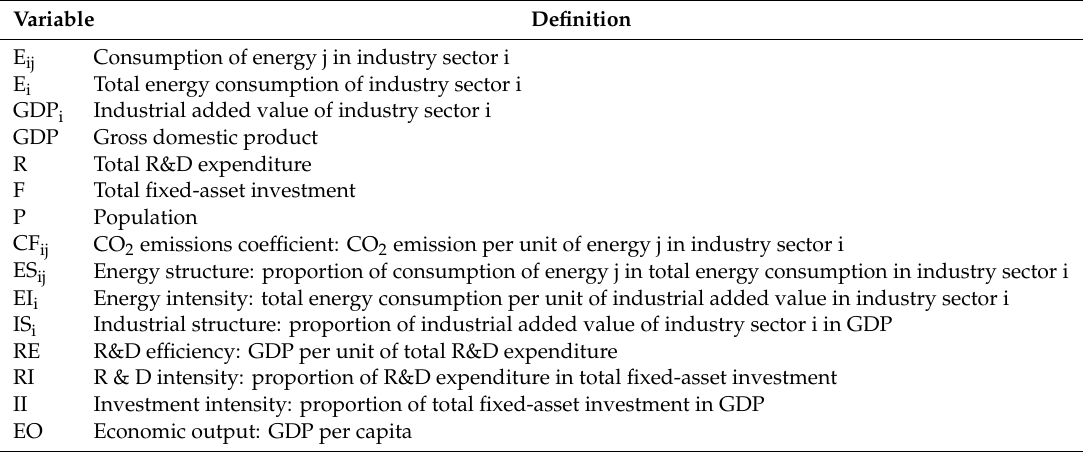
Table 1. Definition of variables in Equation